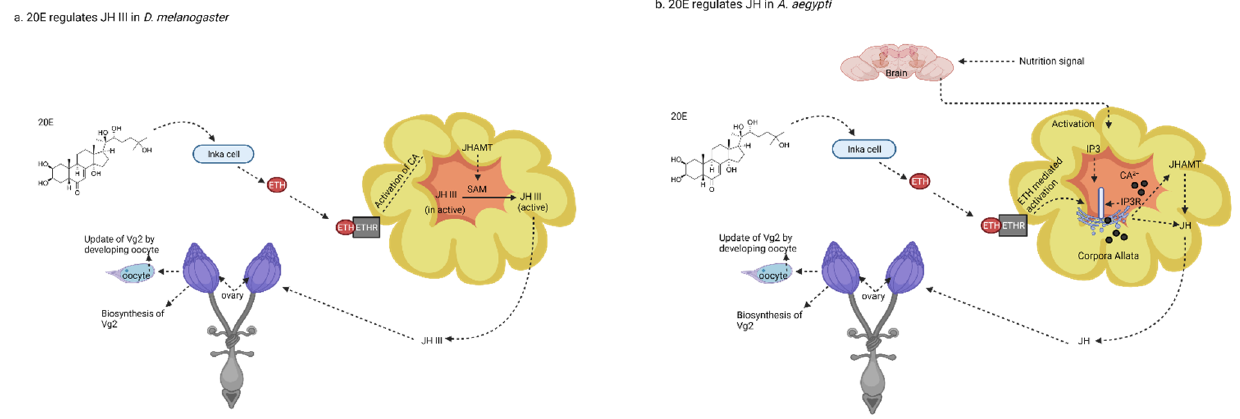
Figure 1. 20E control of female reproduction through regulating juvenile hormones’ (JHs) production. ( a ) 20-hydroxyecdysone (20E) regulates JH III in the fruit fly. In the fruit fly, 20E not only regulates the synthesis and release of ecdysis triggering hormone (ETH) from the Inka cells, but also regulates the expressions of ETHR-B. Later, hemolymph released ETH binds with ETHR-B and activated the corpora allata (CA). However, in the CA, ETH also acts as an allatotropin and increase the activity of juvenile hormone acid methyltransferase (JHAMT). JHAMT regulates the biosynthesis of JHs by converting the inactive JHA III to active JH III in the presence of S-adenosyl methionine (SAM); however, CA released active JH III later regulates biosynthesis of vitellogenin in the ovary. Therefore, it was concluded that the 20E controls the female reproduction, ovary growth, and oocyte maturation by regulating the JHs. ( b ) 20E regulates JHs in the A. aegypti . In A. aegypti , in addition to hormones produced in the ovary, the brain also stimulates the CA to synthesis JHs, after sensing the nutritional signals. However, it was also observed that the ETH controls the JHAMT and JHs’ activity by mobilizing calcium from the endoplasmic reticulum stores, through the IP3 receptor.